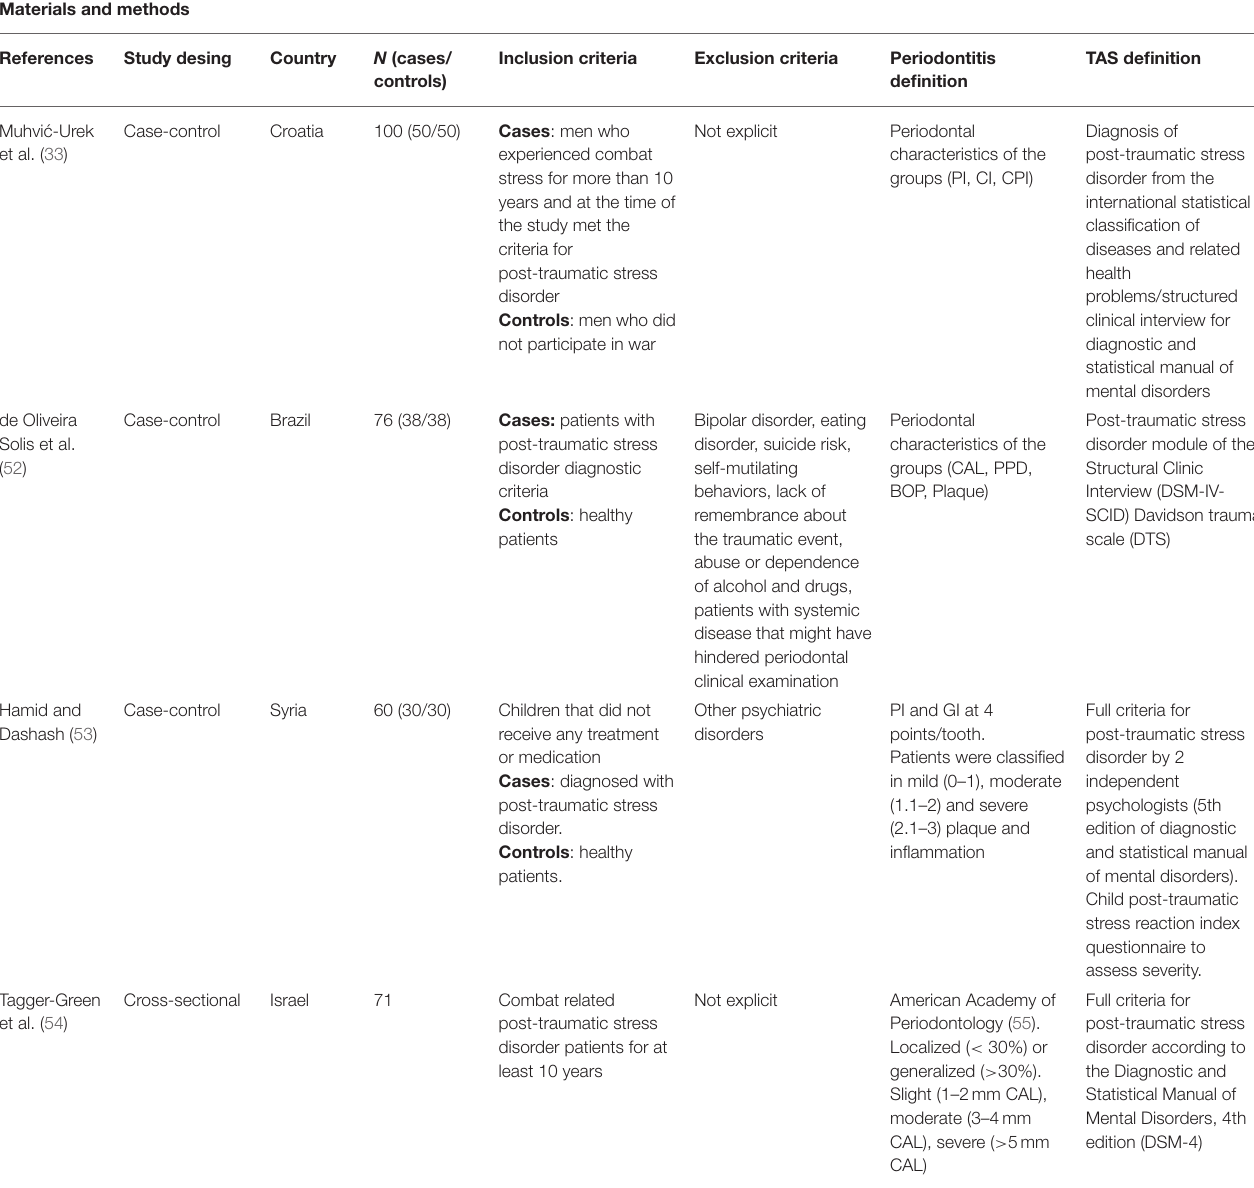
TABLE 2A | Methodology and outcomes of publications studying the relationship between trauma-associated stress and